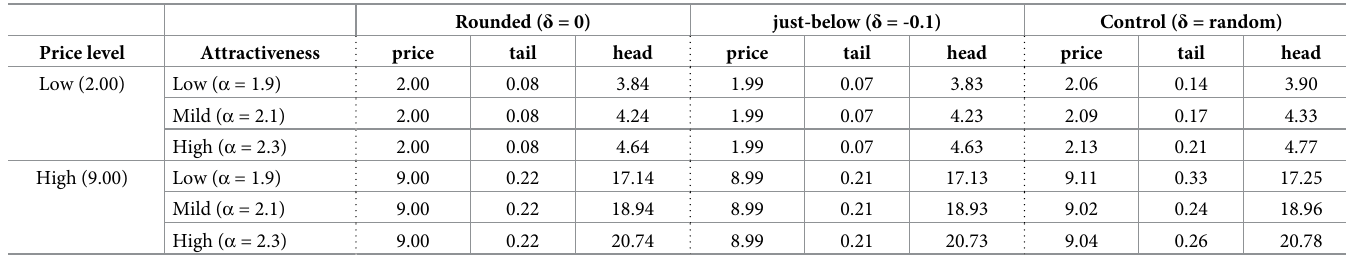
Table 1. Overview of the 18 lotteries-of-interest.